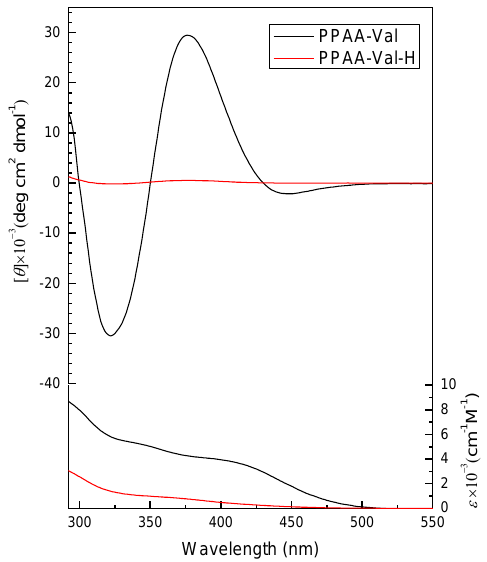
Figure 8. CD and UV-VIS spectra of PPAA-Val and PPAA-Val-H measured in DMF at 25 °C ( c = 1 mg/mL).